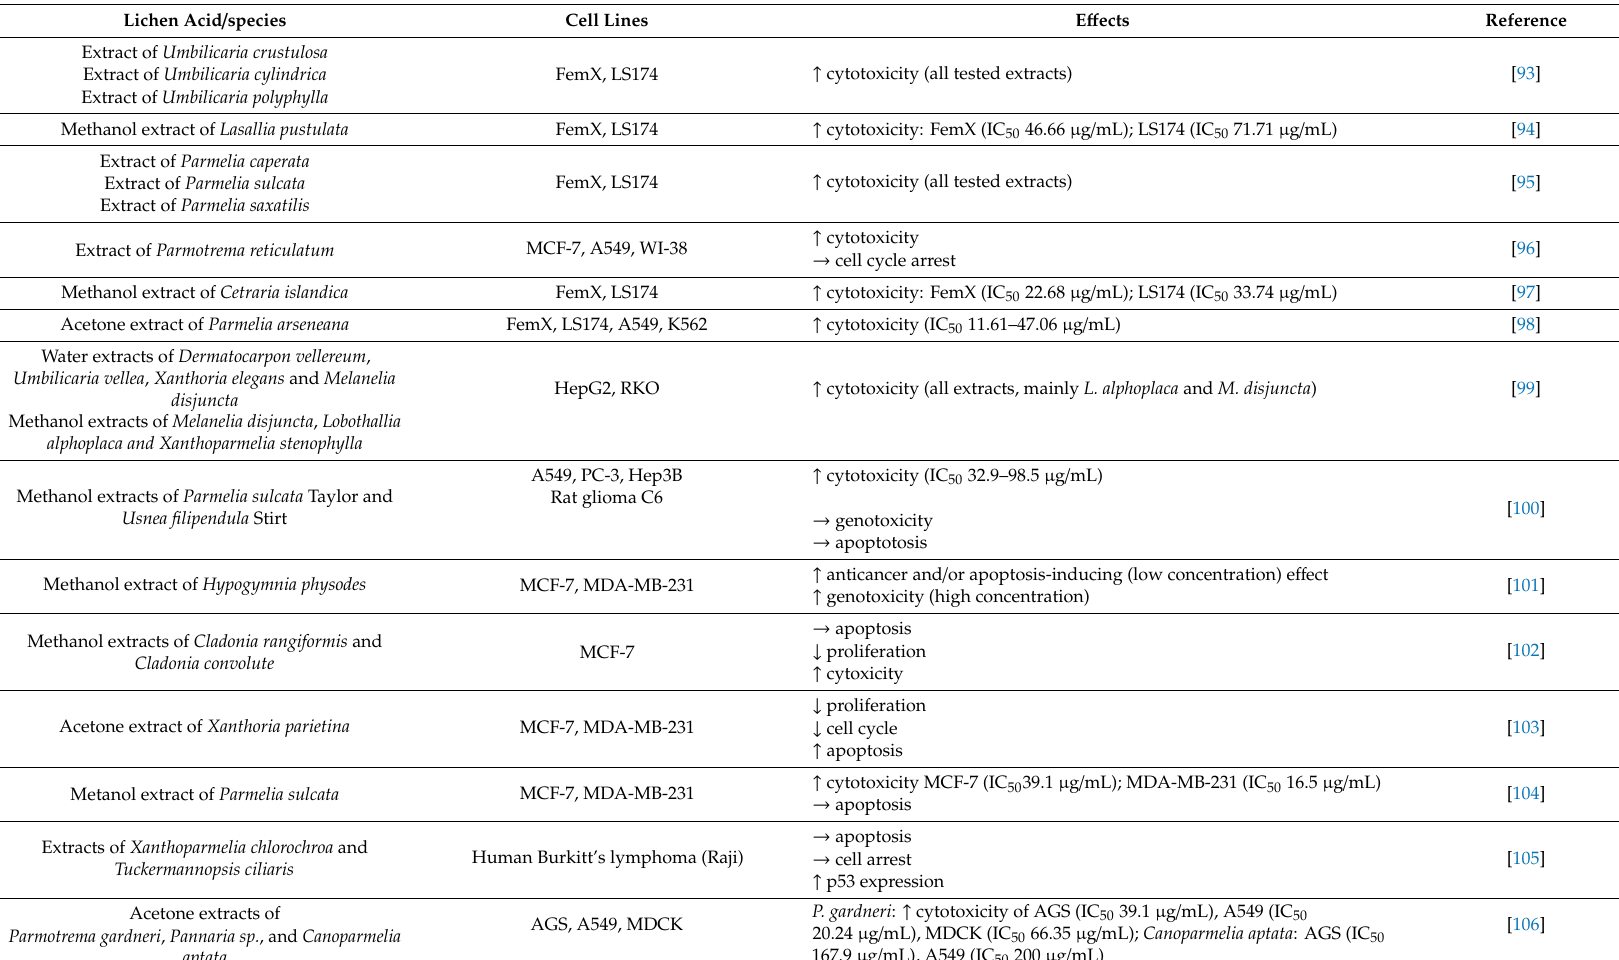
Table 4. Anticancer potential of lichen